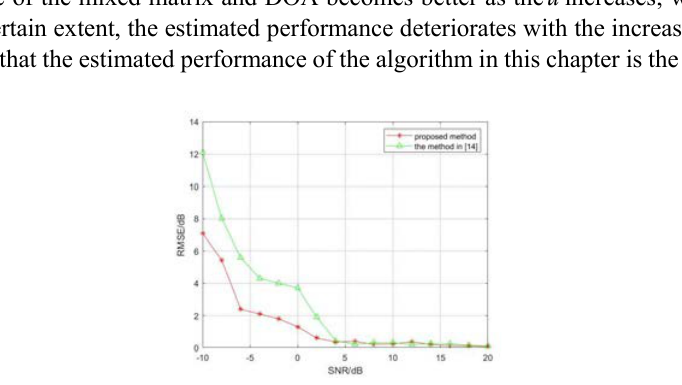
Fig. 5. RMSE changes with